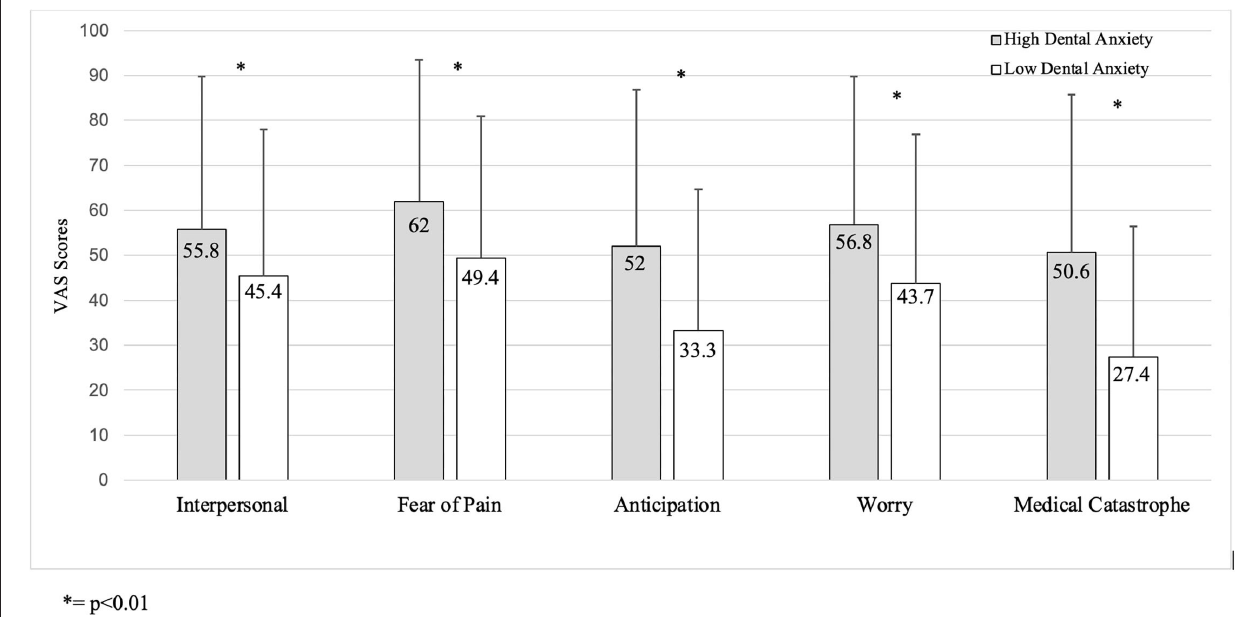
FIGURE 1 | VAS ratings by MDAS dental anxiety scores from Development Phase (higher scores indicate more negative interpretation).